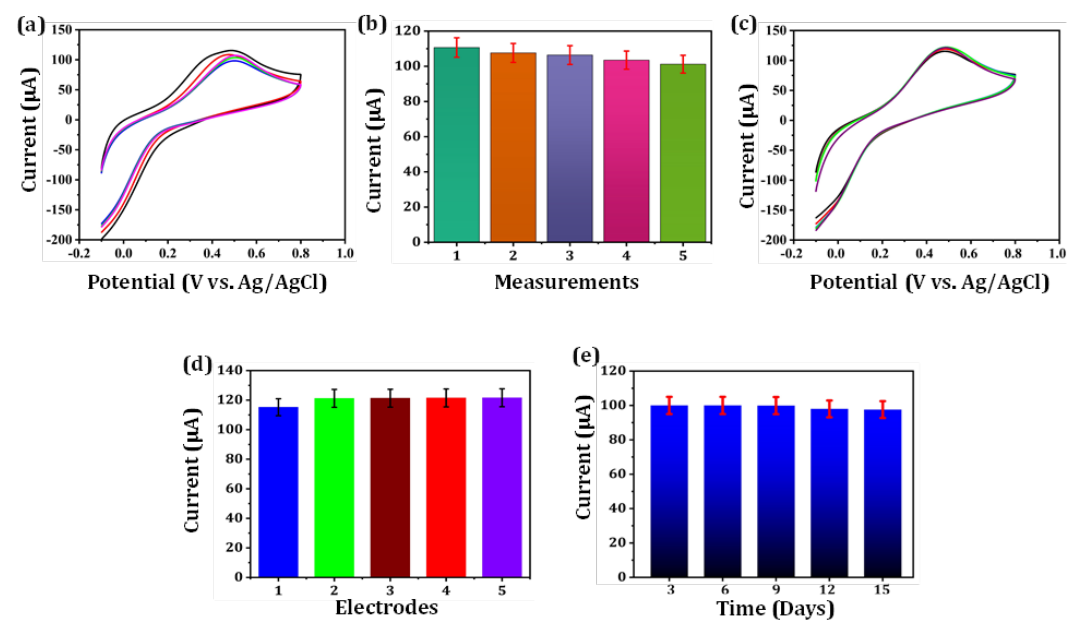
Figure 7. ( a ) Repeatability of the PtNi/SPE for 5 independent measurements in 0.05 M PB (pH-7.0) containing 100 µM sulfide, ( b ) bar diagram of I pa and number of measurements, ( c ) Reproducibility of the PtNi/SPE, ( d ) bar diagram of I pa and number of PtNi/SPE, ( e ) stability bar diagram of PtNi/SPE over 15 days storage.